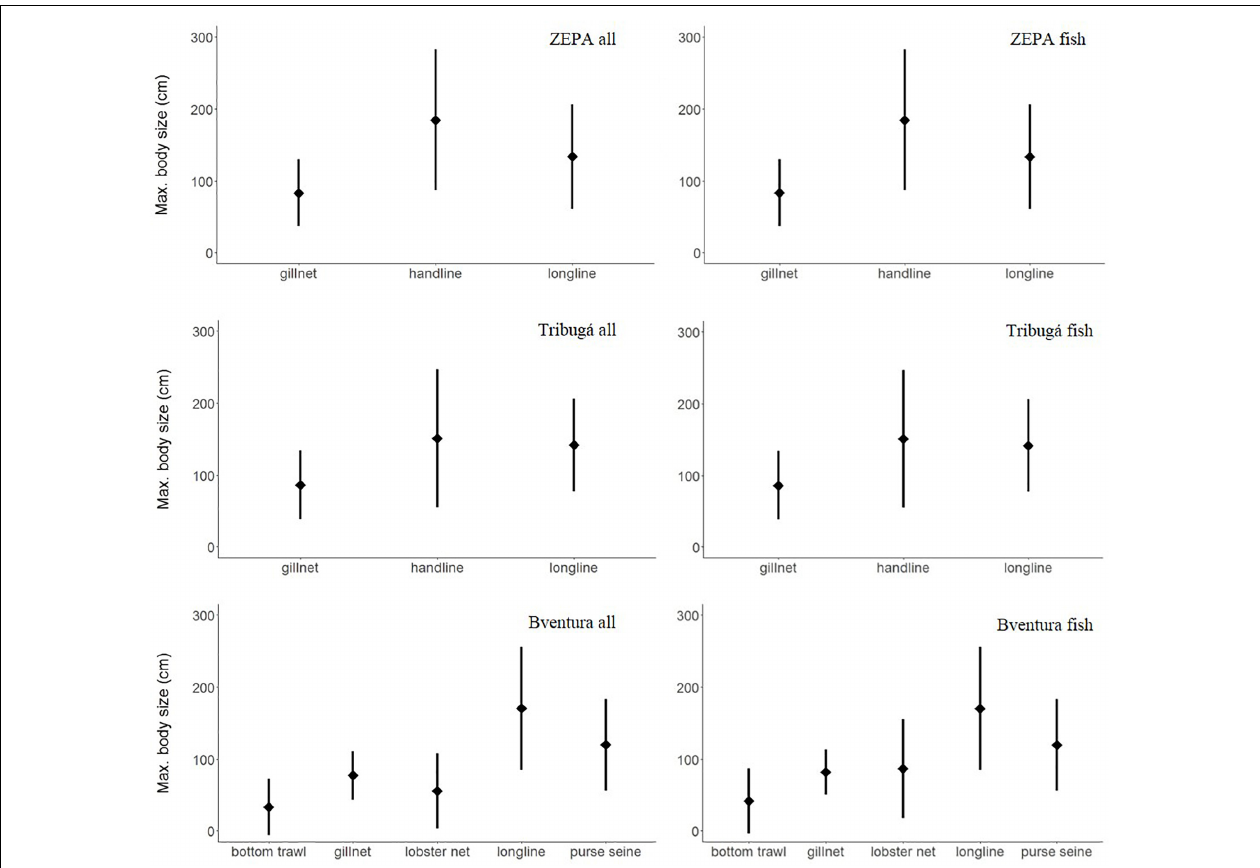
FIGURE 5 | Weighted mean and standard deviation of maximum body size of the entire catch and of the fish portion of the catch of SSF per gear type at three coastal zones of the Colombian Pacific: ZEPA, Tribugá, and Buenaventura (abbreviation: